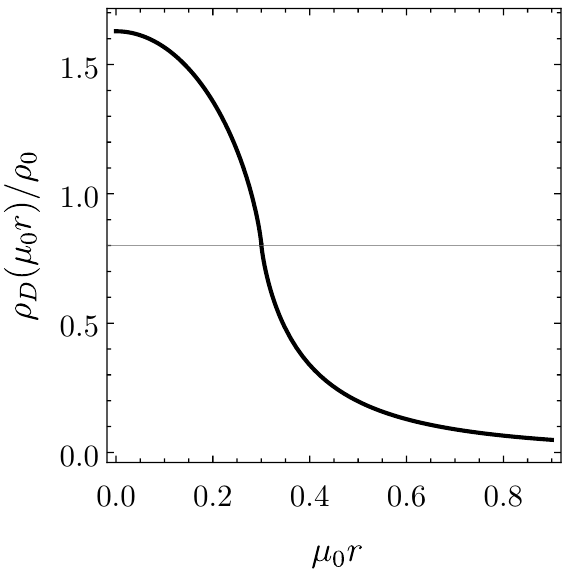
Figure A1. The effective dark matter for a constant density sphere given by Equations (A22) and (A23). Here, ρ D ( ˆ r ) / ρ 0 is plotted versus ˆ r = µ 0 r and we have assumed that ζ 0 = 0 and ˆ r 0 = µ 0 r 0 =